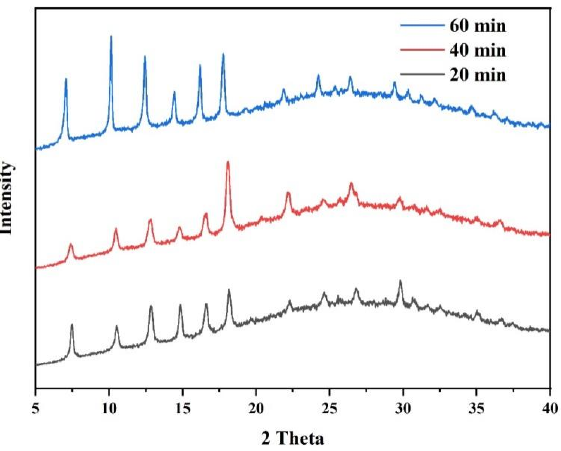
Figure 9. XRD patterns of ZIF-8/AAO membranes with different deposition times.